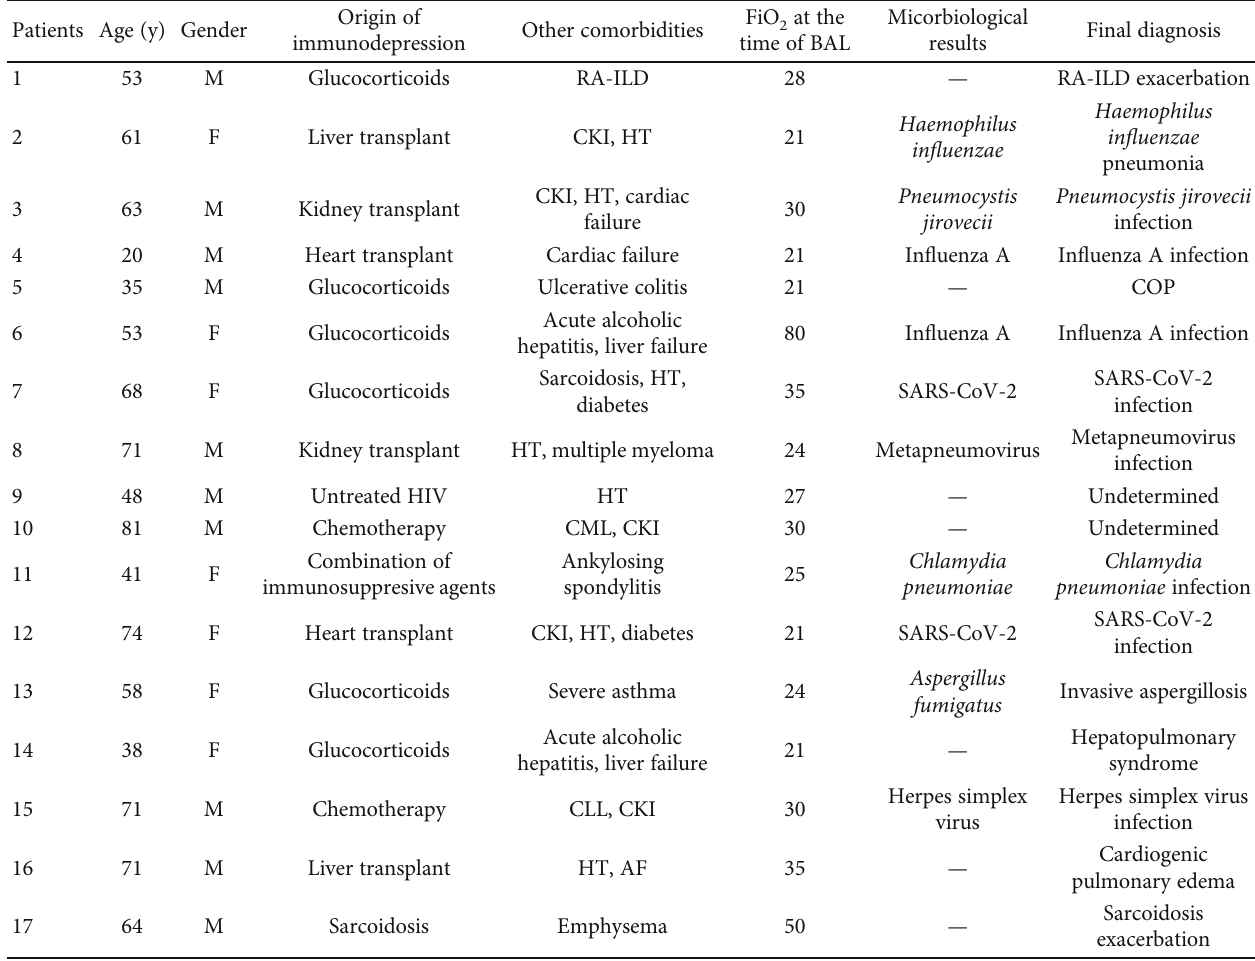
Table 3: Characteristics of immunocompromised patients.